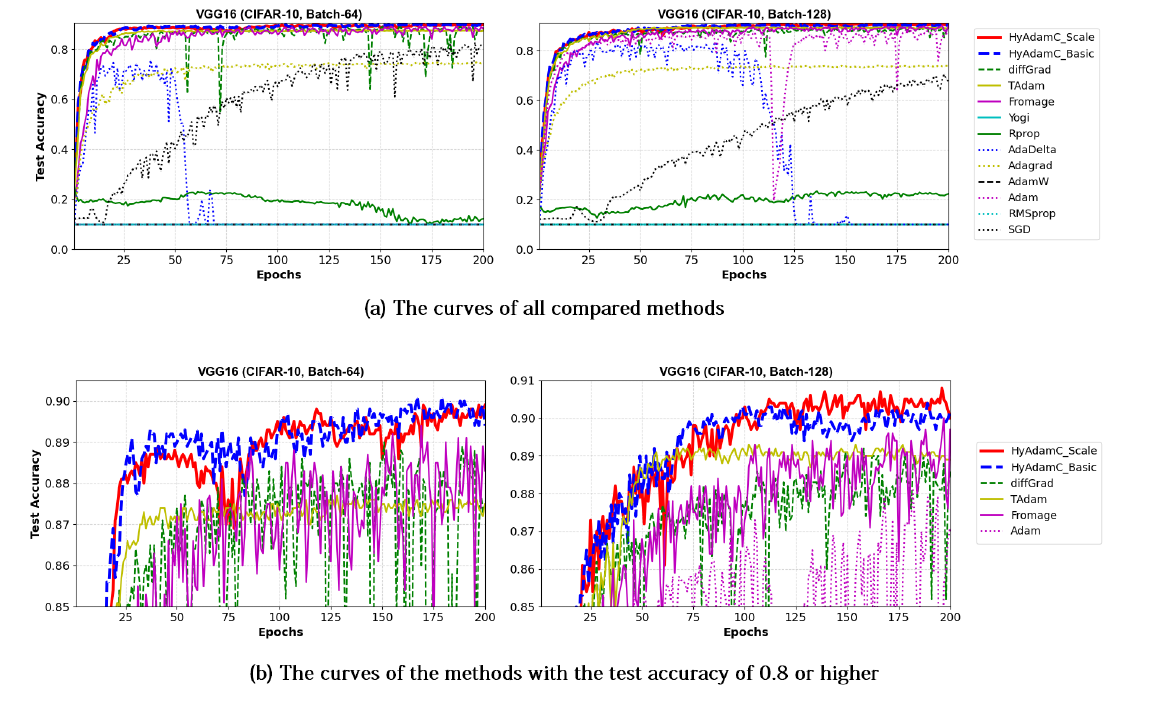
Figure 15. The test accuracy curves of the VGG-16 trained by HyAdamC and other optimization methods in the CIFAR-10 image classification tasks. In this figure, ( a ) shows the test accuracy curves of all compared methods. On the other hand, ( b ) illustrates the plots in which a range of the y-axis of the plots described in ( a ) is zoomed into between 0.85 and 0.9.